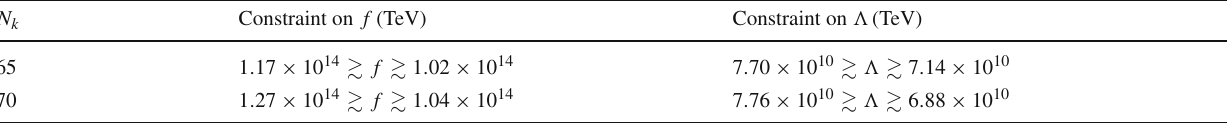
Table 3 Results for the constraints on the mass scales f and (cid:5) for Natural inflation in the high-energy of Randall–Sundrum brane model M 5 = 10 12 TeV, using the last data of PLANCK N k Constraint on f (TeV) Constraint on (cid:5)